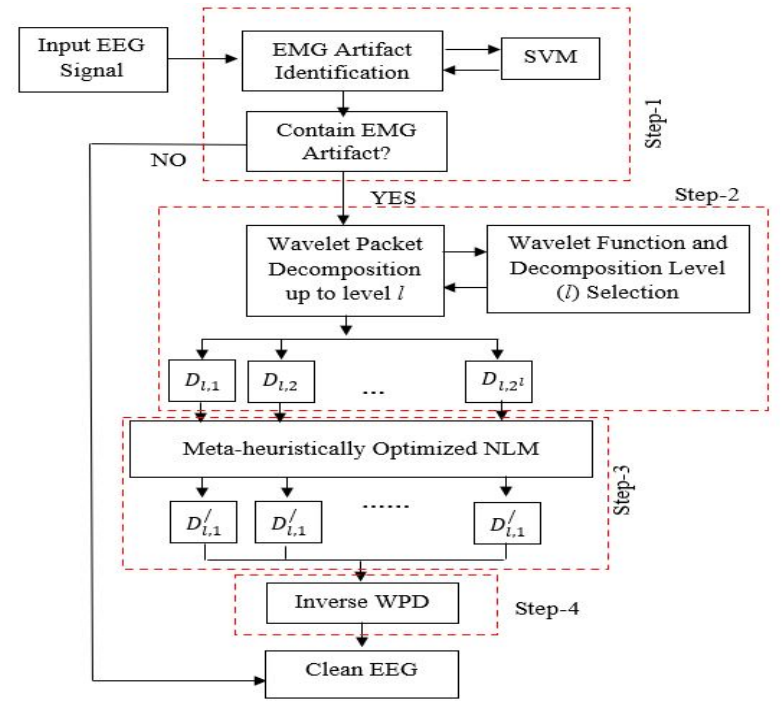
Figure 1. The basic block diagram of the proposed algorithm.